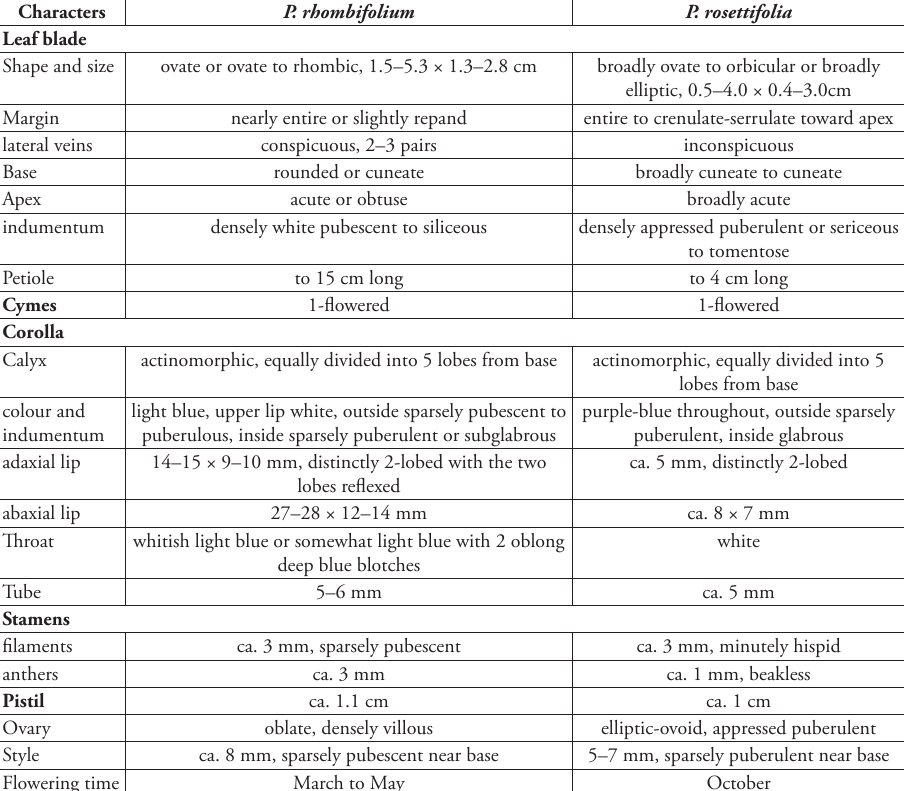
Table 1. Morphological comparison between Petrocosmea rhombifolia sp.nov. and P. rosettifolia C. Y. Wu ex H. W.